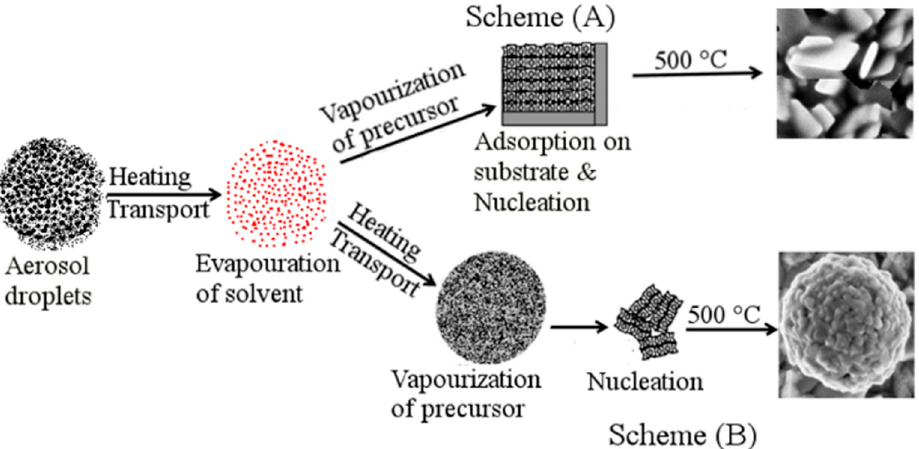
Figure 3. A diagrammatic representation of probable development process of nanoplate and hierarchical buckyball-shaped microsphere structures formation during AACVD process. buckyball-shaped microsphere structures formation during AACVD